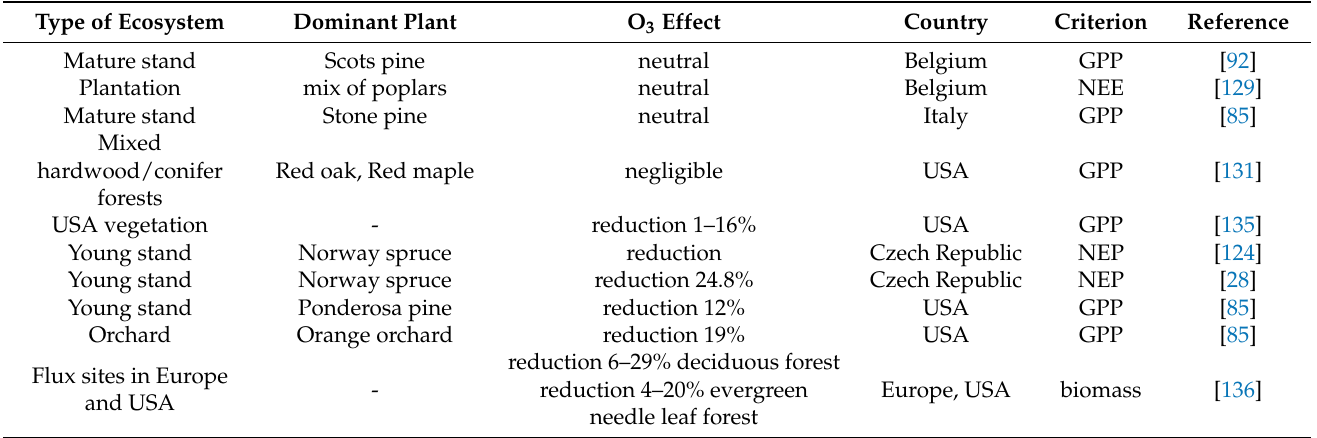
Table 2. Effects of O 3 on various carbon-related criterion. GPP—gross primary production, NEE—net ecosystem exchange, NEP—net ecosystem